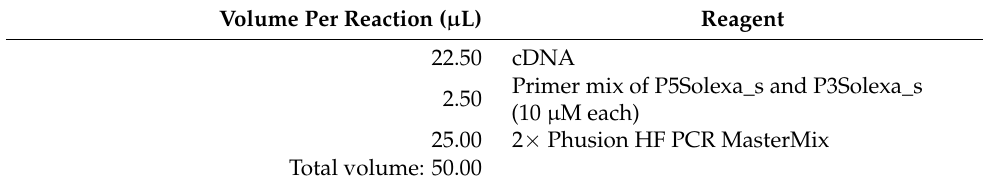
Table 10. PCR Mix for cDNA